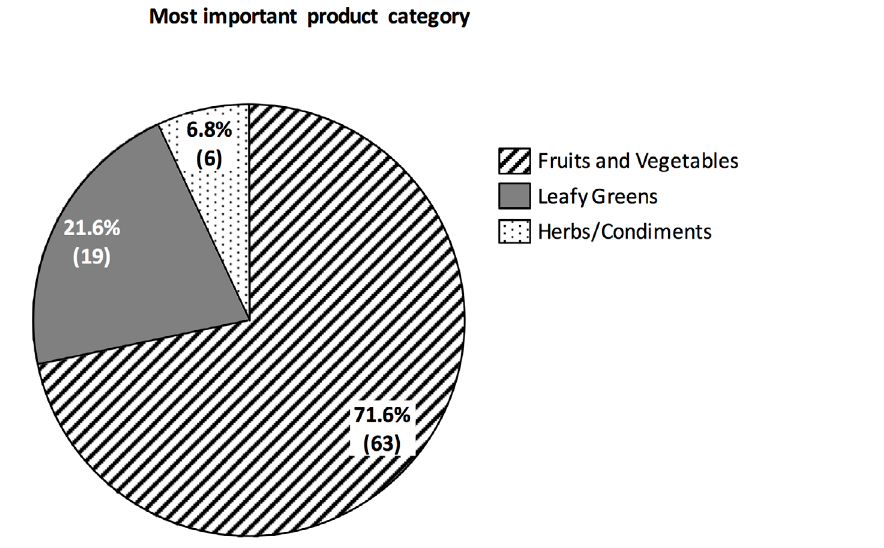
Figure 7: The 85% of respondents indicating that the availability of fresh fruit, vegetables and herbs grown on the Neumayer Station (85%, 88 individuals) would improve their overall well-being were asked to indicate which category was most important to them. Only one answer was